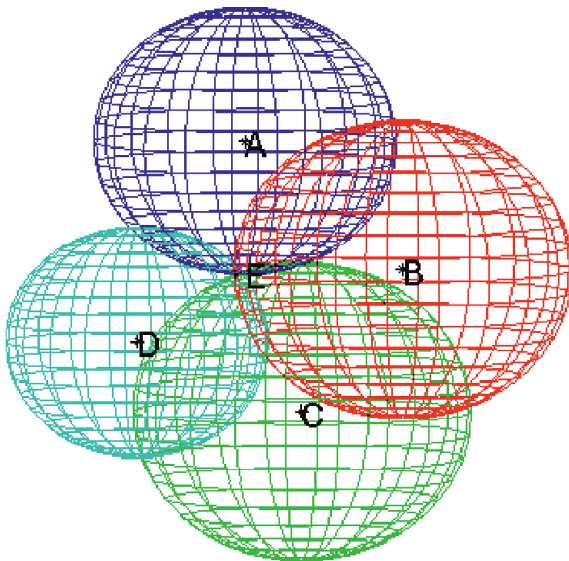
Figure 2: Schematic diagram of 3D measurement